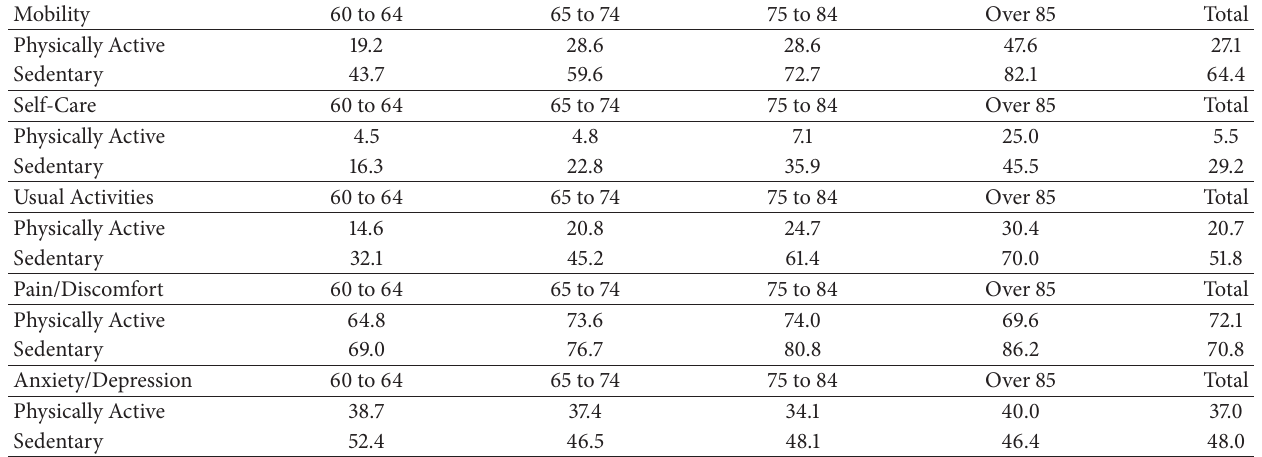
Table 3: Percentage of women with problems in EQ-5D dimensions according to age and physical activity